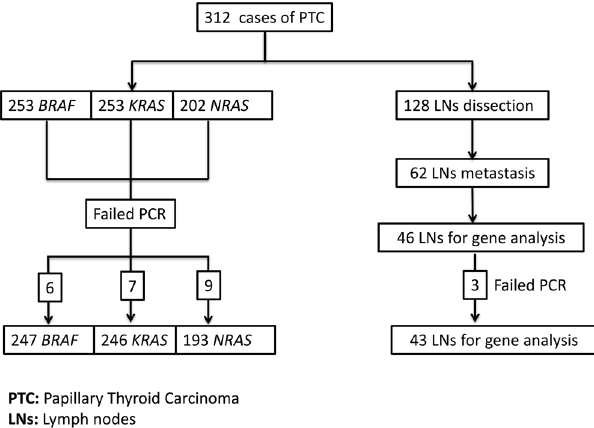
Figure 1. Stratification of the 312 cases of PTC included in our